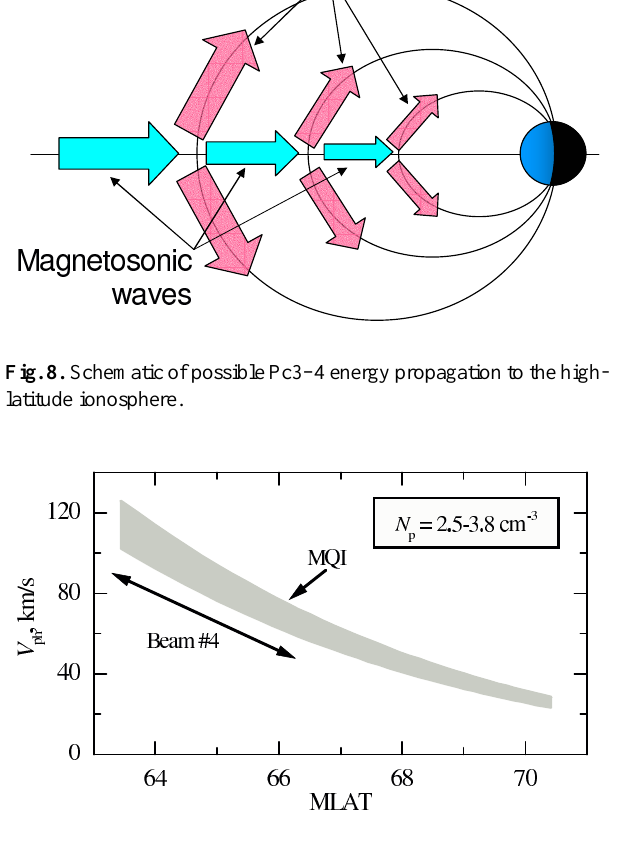
Fig. 9. Estimates of the meridional Pc3–4 wave phase velocity for the model in Fig. 8 (dipole magnetic field, magnetopause